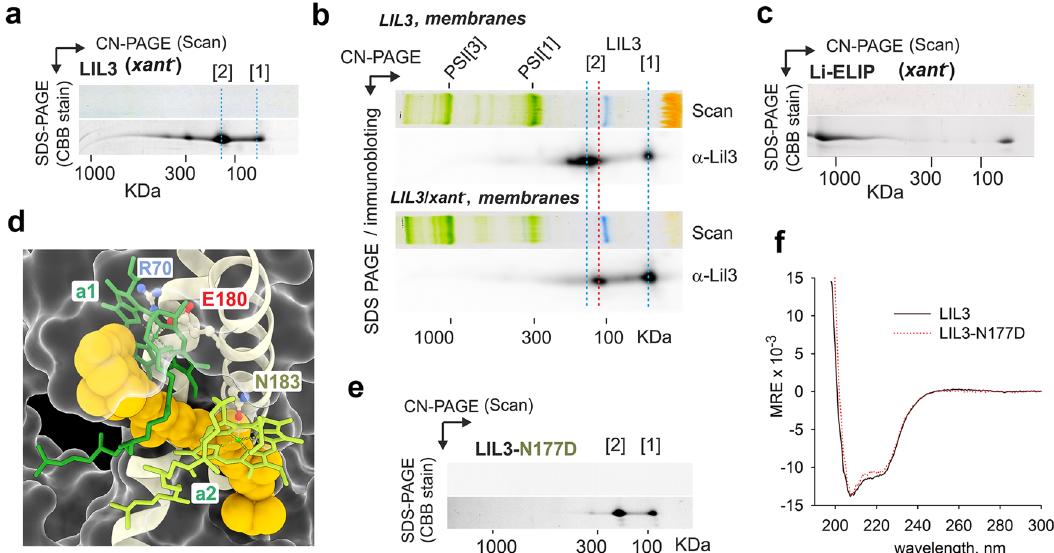
Fig. 5 Carotenoid speci fi city, dimerization, and mutagenesis of LHC-like proteins produced in Synechocystis . a LIL3 was expressed in the Synechocystis xant − background containing synechoxanthin and β -Car as the only carotenoids (see Supplementary Fig. 9a). Puri fi ed LIL3 was separated by 2D CN/SDS- PAGE and the gel stained by Coomassie Blue (CBB). b Solubilized membrane proteins isolated from the Synechocystis strain expressing LIL3 ( LIL3 strain) and from the LIL3 / xant − were separated by 2D CN/SDS-PAGE. The SDS-gel was blotted, and the LIL3 protein was detected by a speci fi c antibody. c Li-ELIP puri fi ed from the xant − background was separated by 2D CN/SDS-PAGE and the gel stained by CBB. d A detail of lutein ( lut 1) binding site in pea LHCII protein (PDB code 2BHW 23 ). Chl molecules coordinated by E180 (Chl a 1, forest green) and N183 residues (Chl a 2, light green) close the lutein-binding cavity. Lutein is depicted as a yellow, space- fi lling model. e The puri fi ed LIL3-N177D protein was separated by 2D CN/SDS-PAGE, showing that the N177D mutation abolishes pigment binding. N177 residue in LIL3 corresponds to N183 Chl ligand in LHCII. f CD spectra in the UV region of LIL3 and the N177D LIL3 mutant normalized per residue (MRE mean residue